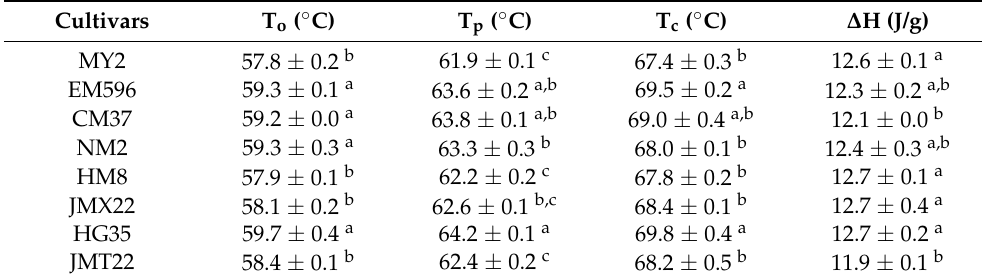
Table 3. Thermal properties of starch from wheat varying in grain hardness index.